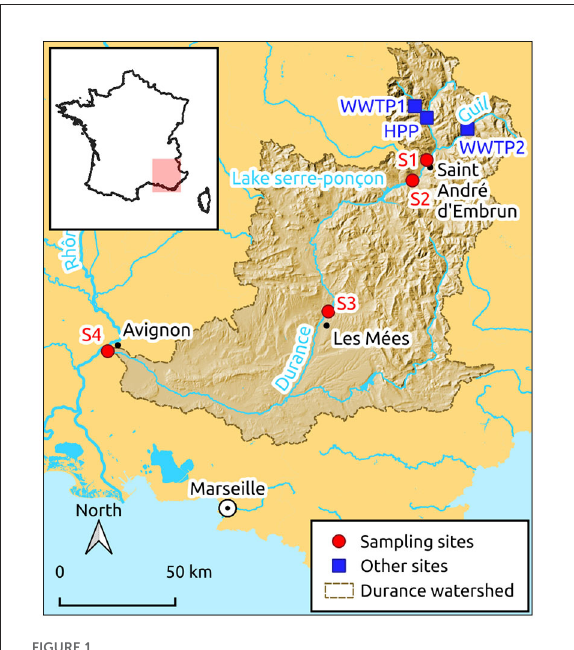
FIGURE1 Map of Durance watershed, study sites, and other sites mentioned in the